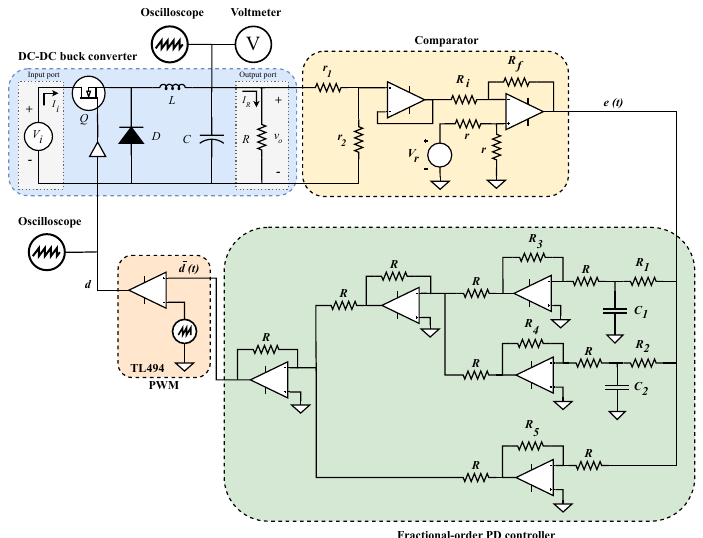
Figure 13. Electrical arrangement for implementation of control diagram from Figure 2 where plant, controller, comparator and PWM blocks can be